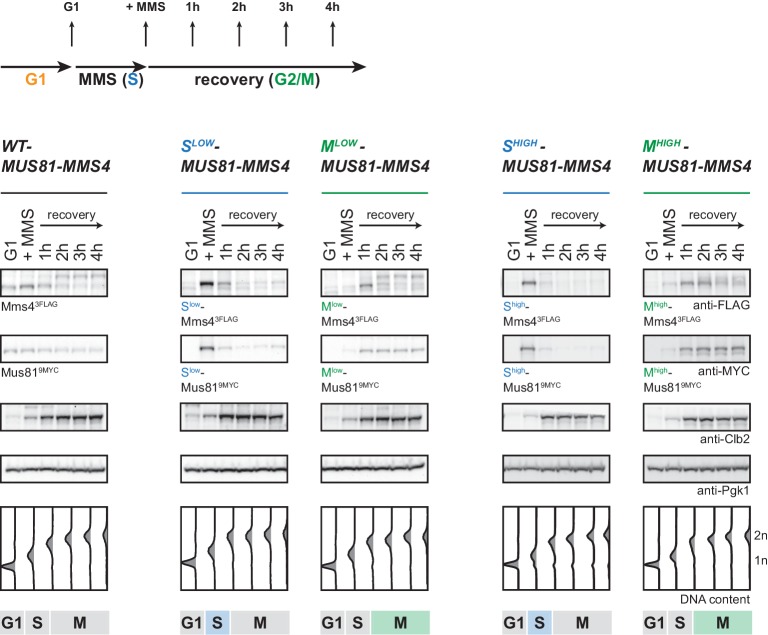
Cell cycle tags restrict efficiently to S or M phase also after DNA damage treatment.Western blot analysis of WT cells (left), of cells expressing Slow-Mus81-Mms4 or Mlow-Mus81-Mms4 (middle) and of cells expressing Shigh-Mus81-Mms4 or Mhigh-Mus81-Mms4 (right) S- and M-tagged Mus81-Mms4 recovering from a pulse of MMS (0.033%, 1 hr) as in Figure 4B/C. Rise in Clb2 levels are coincidental with entry into M phase. Pgk1 serves as control.